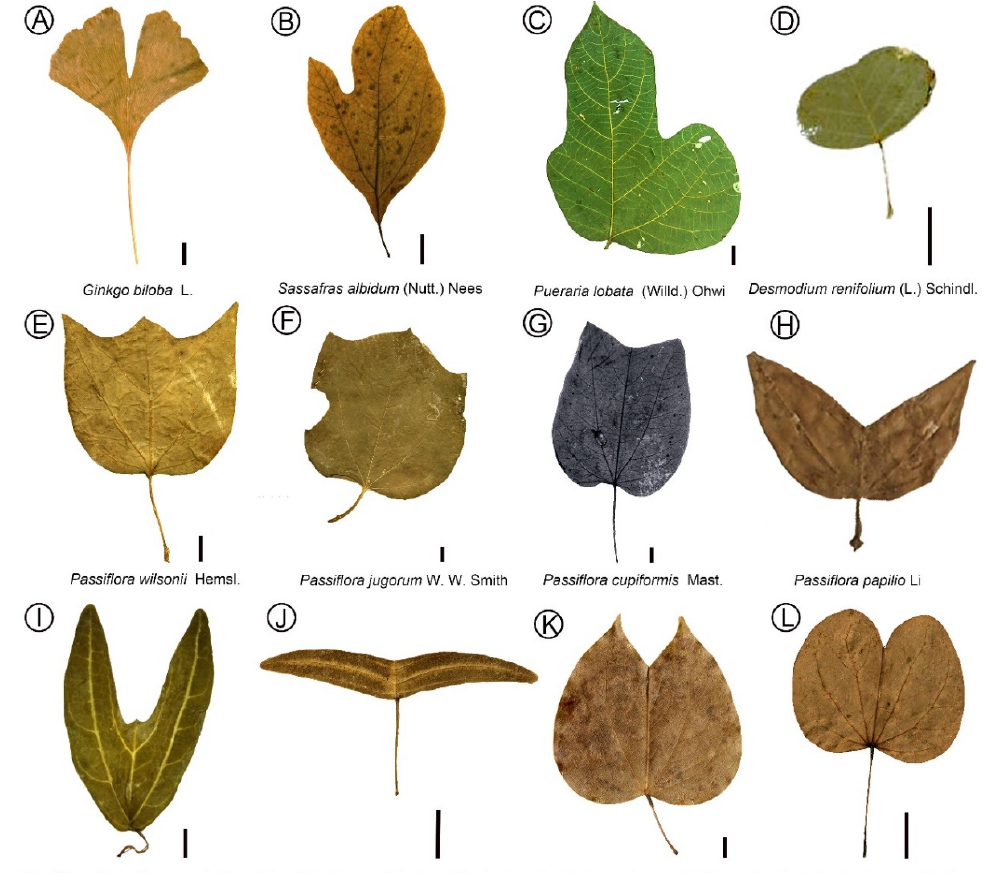
Figure 7. Leaf morphologies of bilobed or bilobe-like leaves in Ginkgoaceae Engl. ( A ) Lauraceae Juss. ( B ), Passifloraceae Juss. ex Roussel ( E – I ), and Leguminosae Juss. ( C , D , J – L ). The scale bars represent 1 cm.